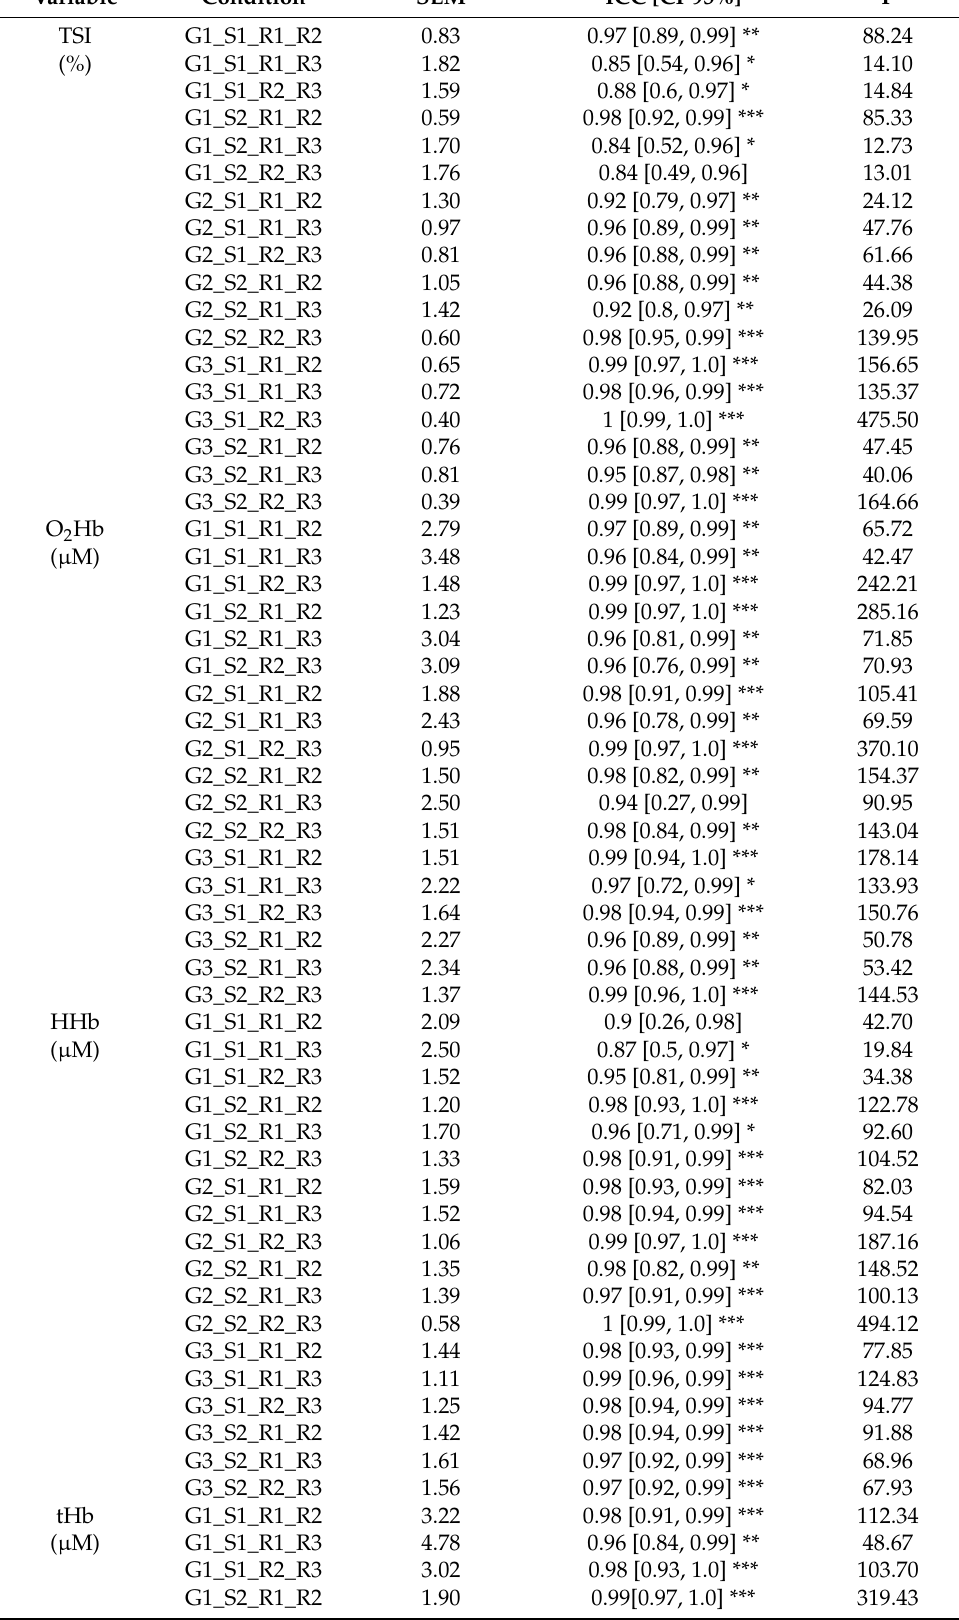
Table 5. Within-participant reliability for